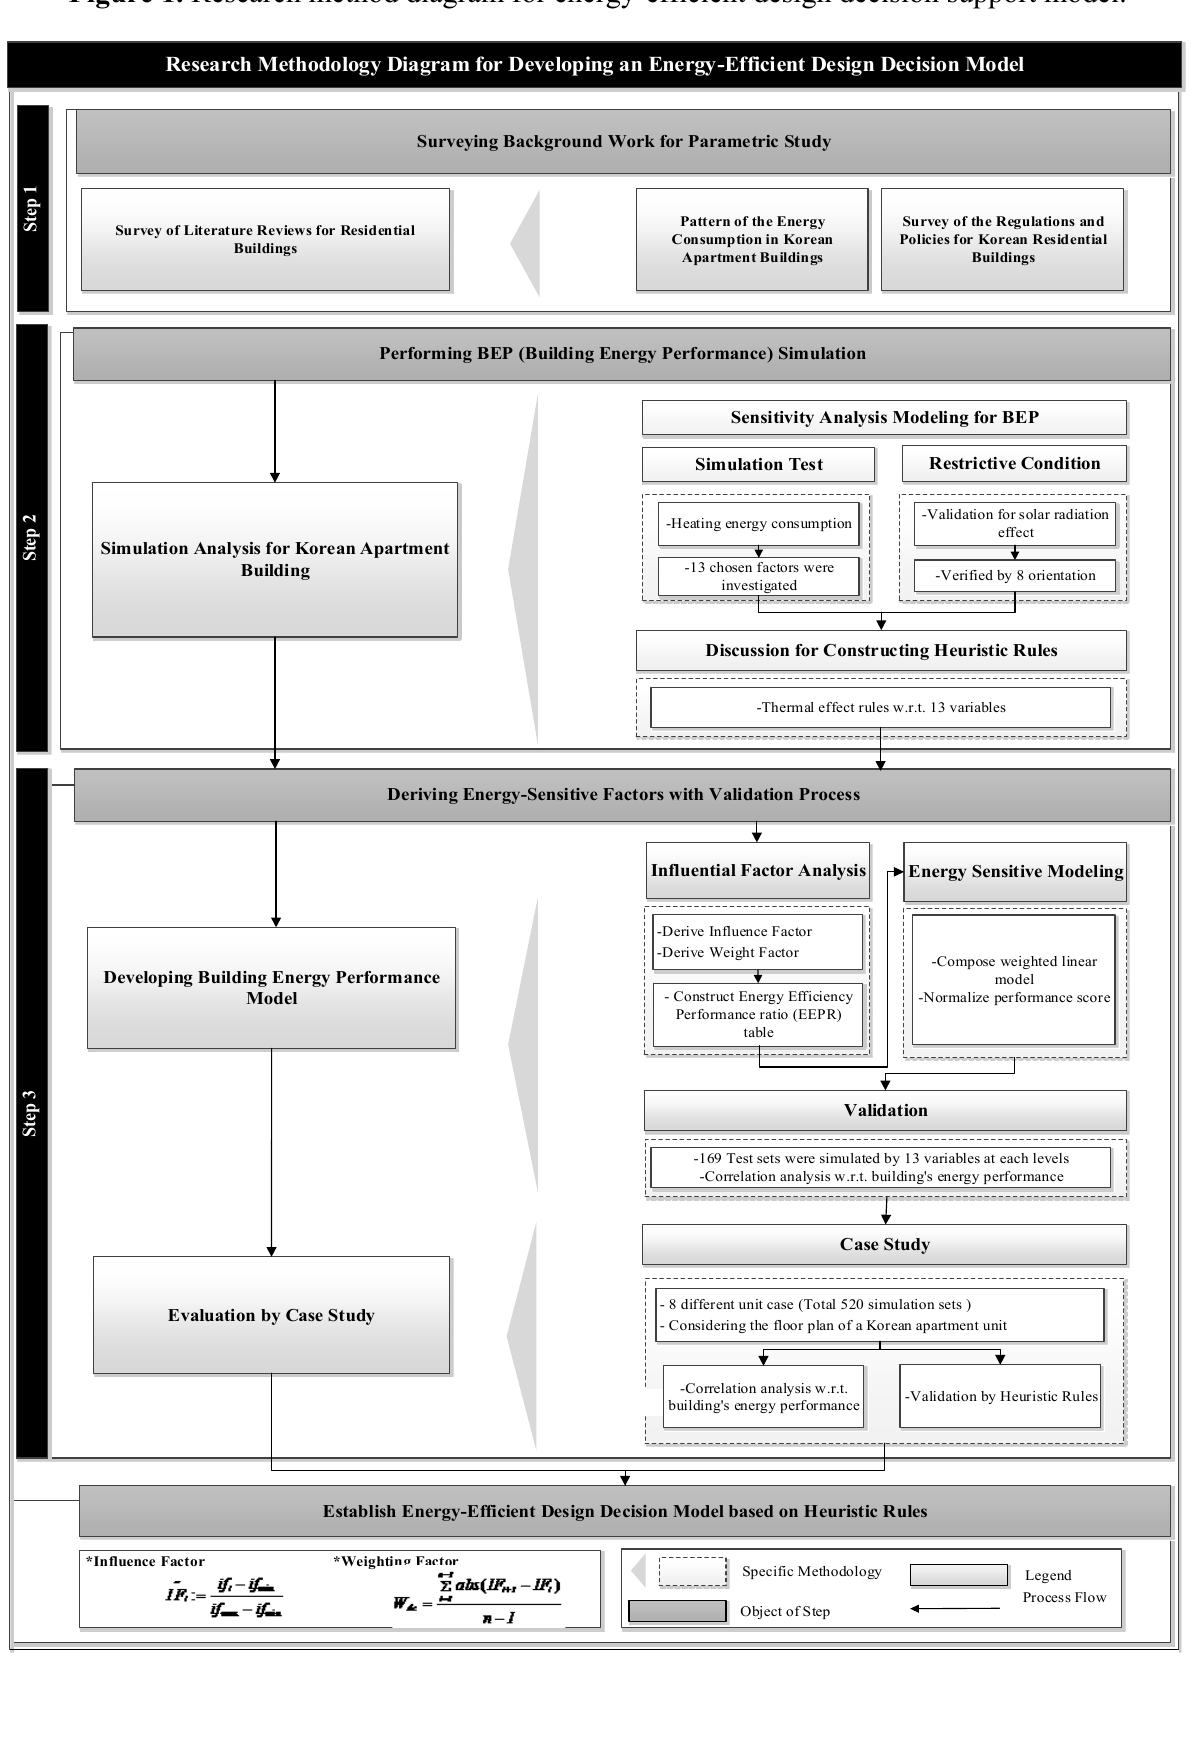
Figure 1. Research method diagram for energy-efficient design decision support model.